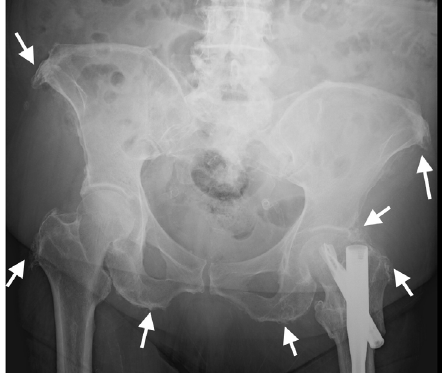
Figure 8. AP radiograph of the pelvis of an 82-year-old female with thoracic DISH (not shown). Characteristic whiskering of the anterior superior iliac spine and ischial tuberosities (arrows) is present on both sides, resulting from enthesopathy in these regions.